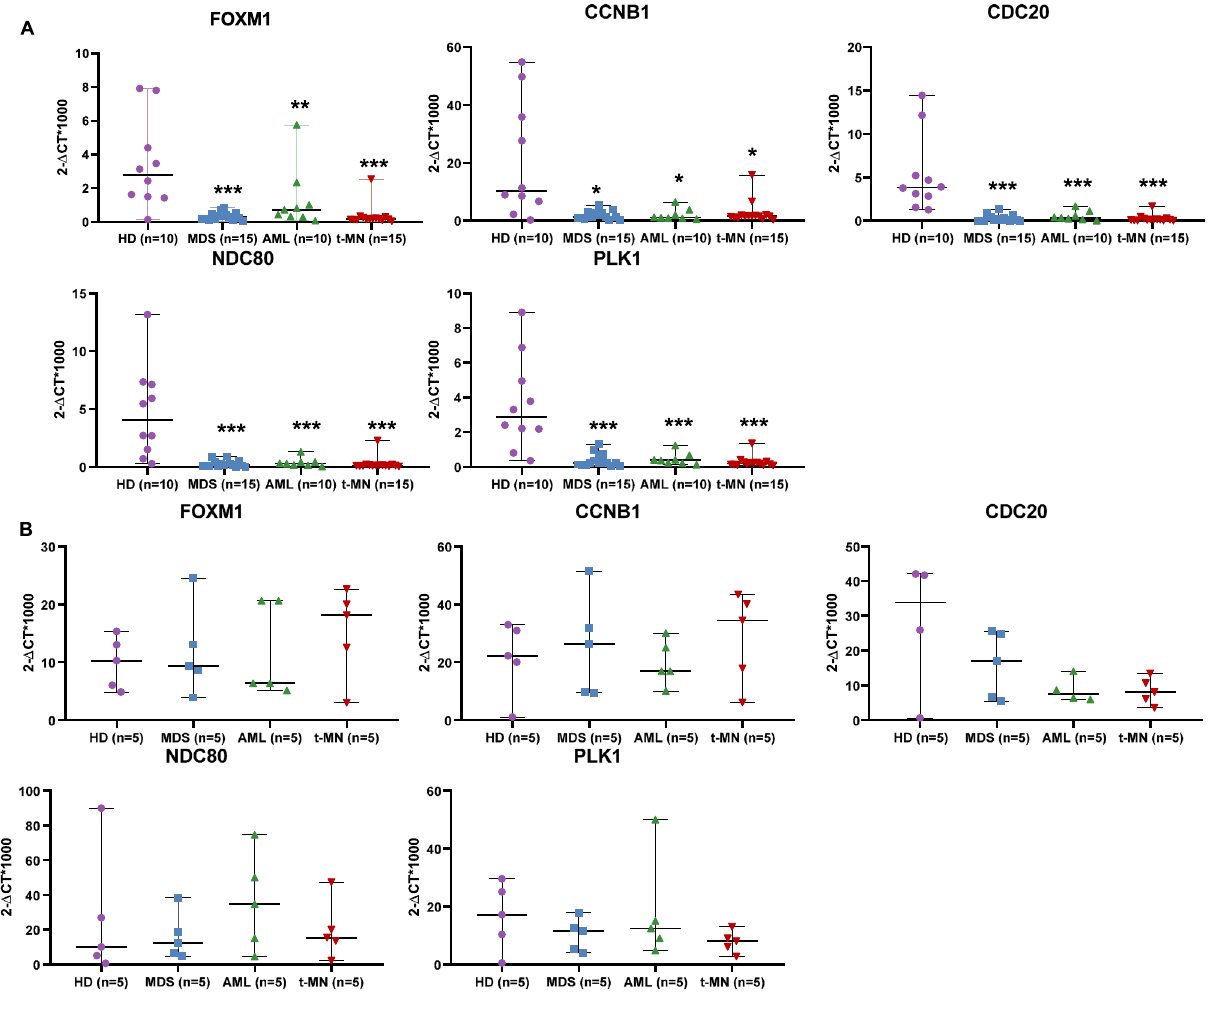
Figure 2. Expression levels of FOXM1 and its mitotic genes ( A ) mRNA expression levels of FOXM1 and its mitotic targets ( CCNB1, CDC20, NDC80, PLK1 ) in MSC isolated from patients with myeloid neoplasms (MDS n = 15, AML n = 10, t-MN n = 15) as compared to healthy donors (HD, n = 10). ( B ) mRNA expression levels of FOXM1 and its mitotic genes ( CCNB1, CDC20, NDC80, PLK1 ) in MNC isolated from patients with myeloid neoplasms (MDS n = 5, AML n = 5, t-MN n = 5), as compared to healthy donors (n = 5). The gene expression values, specific for each gene, are presented as 2-ΔCt*1000, where ΔCt is Ct (test gene)—Ct ( GAPDH housekeeping gene). The comparison between patient and control groups was performed using a nonparametric Mann–Whitney U test. * p < 0.005, ** p <